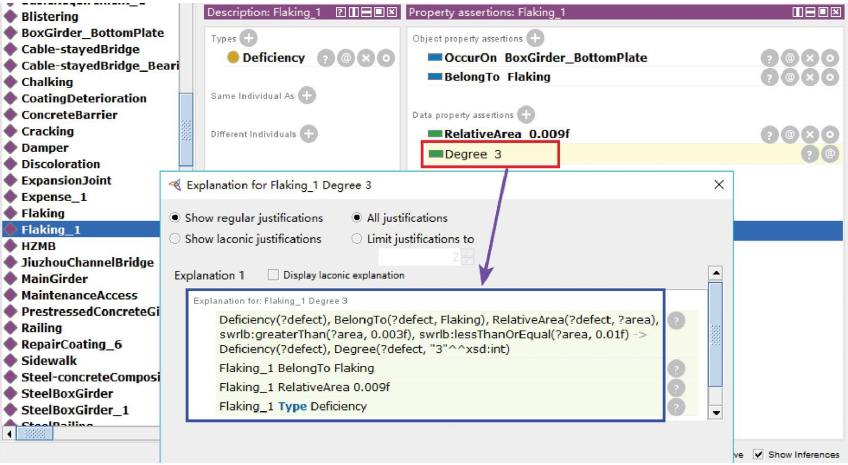
Figure 10: Te result of rule reasoning. Table 2: Rating scheme for designating the degree of faking